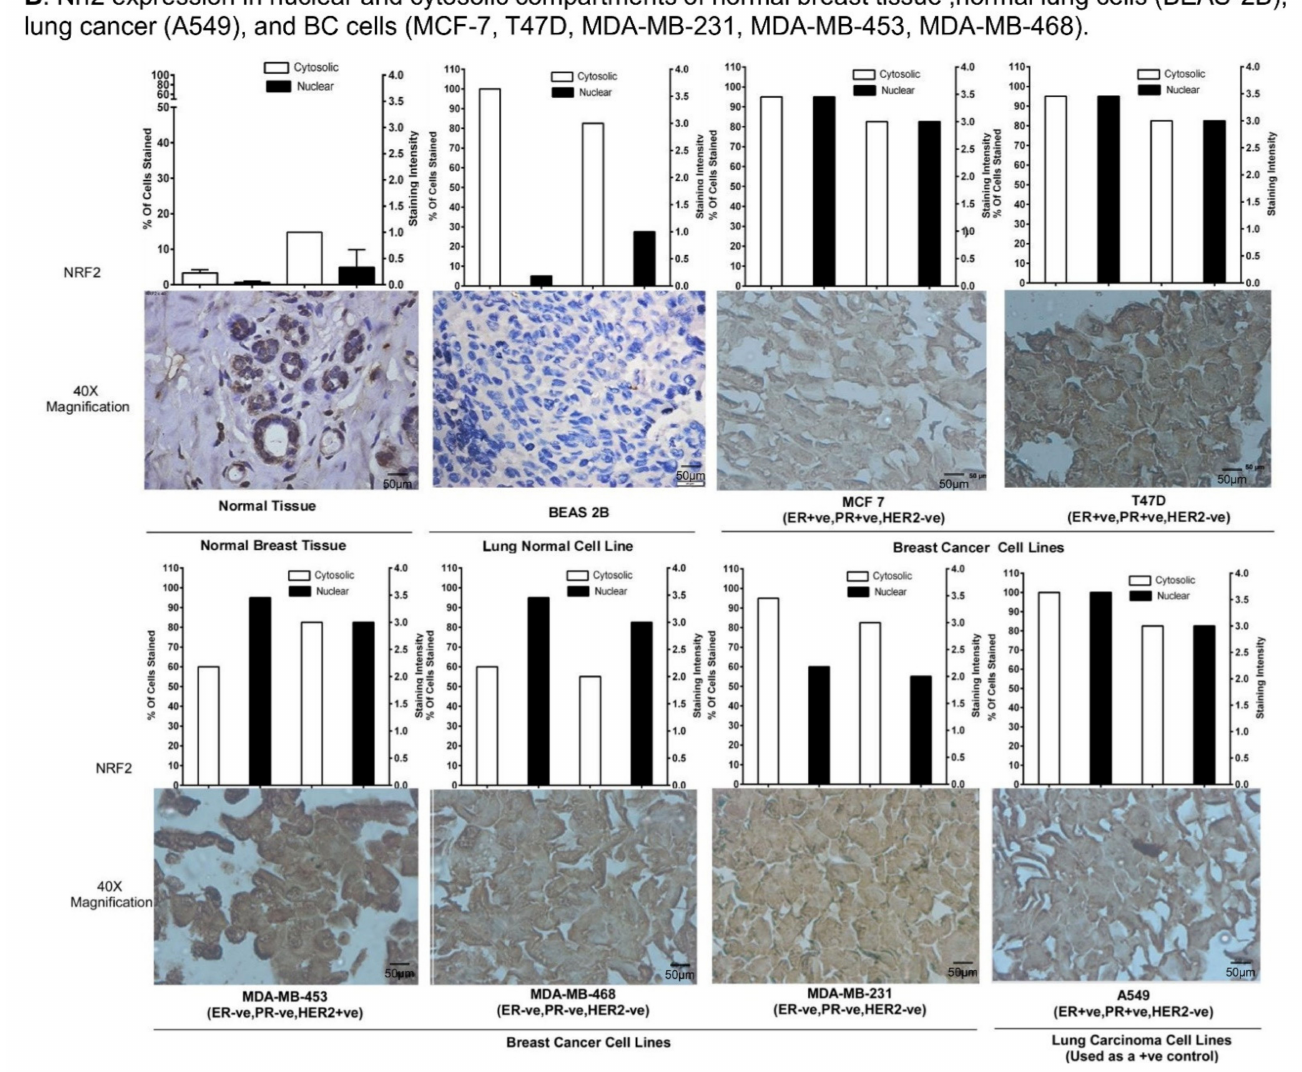
Figure 1. IHC analysis of Nrf2 expression in BC tissues and cell lines: ( A ) Nrf2 expression in normal and grade-II/III BC tissues: The expression of Nrf2 in normal breast tissues (n = 3), grade-II (n = 14), and grade-III (n = 29) BC tissues was analyzed by IHC. Representative microphotographs (40X magnification images) are shown. Please refer to Supplementary Figure S1 for the tissue array preparation procedure. Expression of Nrf2 in cytosolic and nuclear compartments of the same cells/tissues was compared and was not found significantly different. ( B ) Elevated Nrf2 was observed in breast cancer cell lines MCF-7, T47D, MDA-MB-453, MDA-MB-231, MDA-MB-468, and in lung cancer cell line A549. Expression of Nrf2 was visualized using immunocytochemistry (IHC). Irrespective of ER, PR, and HER2 expression status, all BC cell lines and A549 exhibited higher level of Nrf2 compared to normal breast tissue and lung cells. Total cell number was counted for each image. Representative microphotographs (40X magnification, Scale:50 µ m) are shown. ns refers to